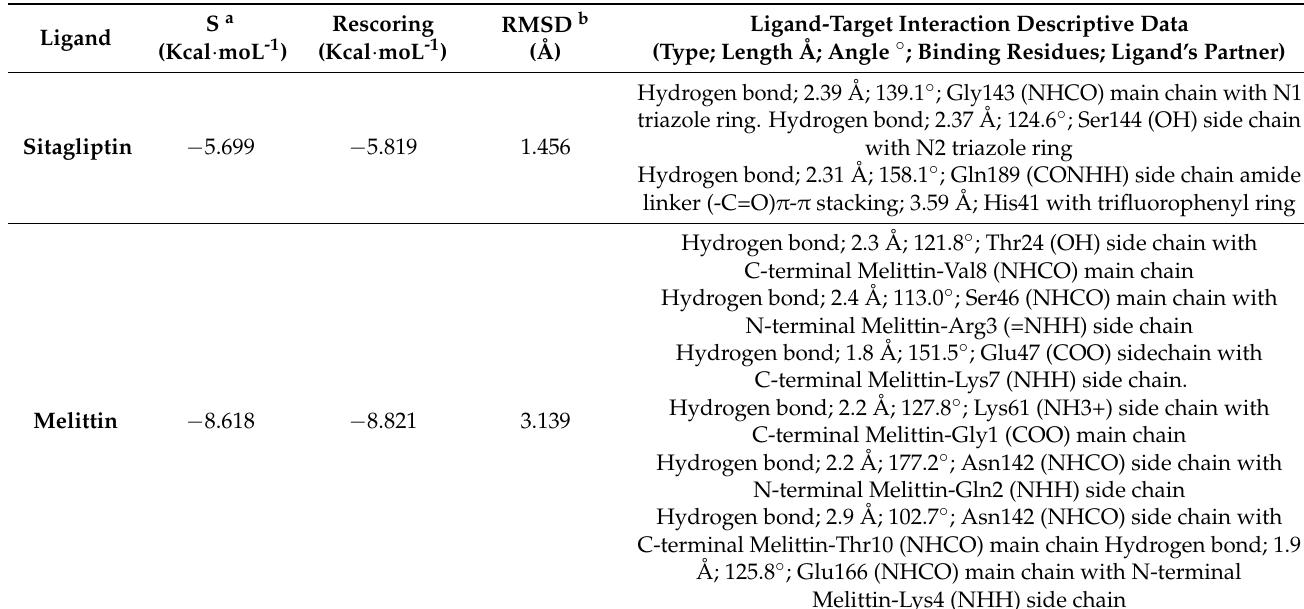
Table 4. Ligand-3CL pro binding interaction